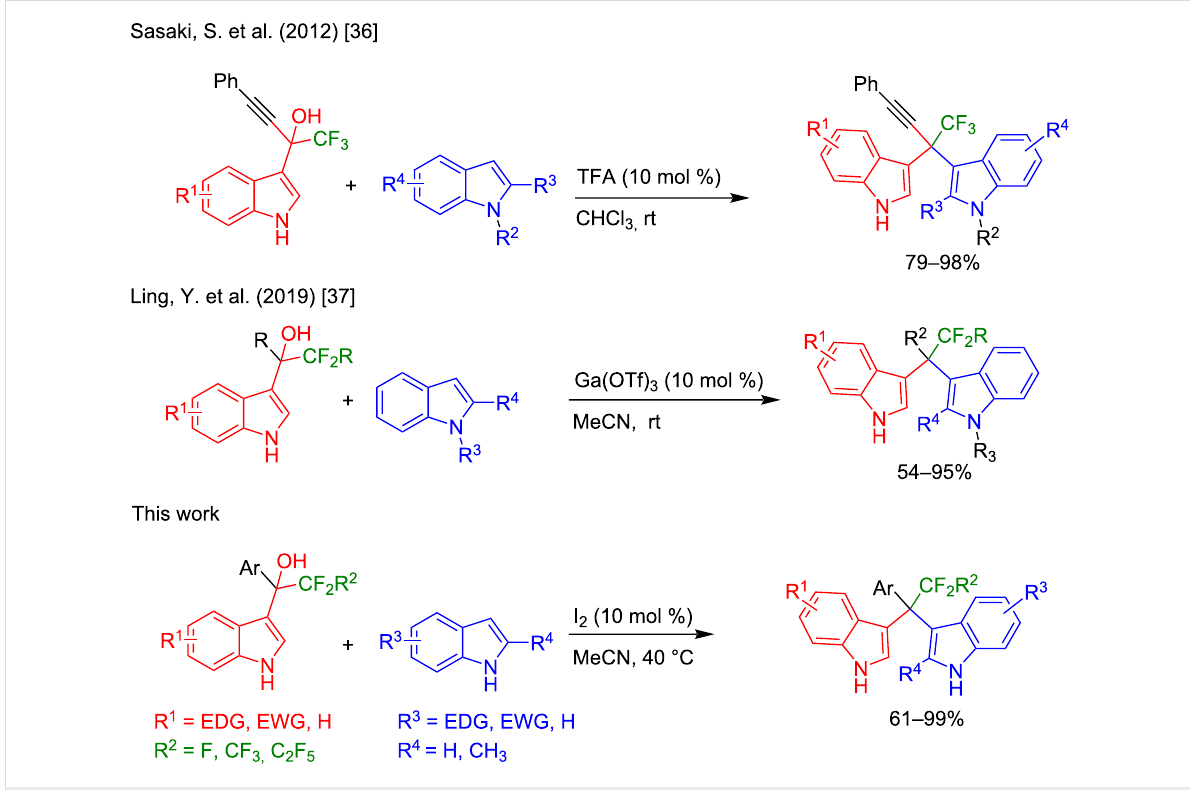
Figure 2: Synthetic strategies toward trifluoromethylated unsymmetrical quaternary DIMs.